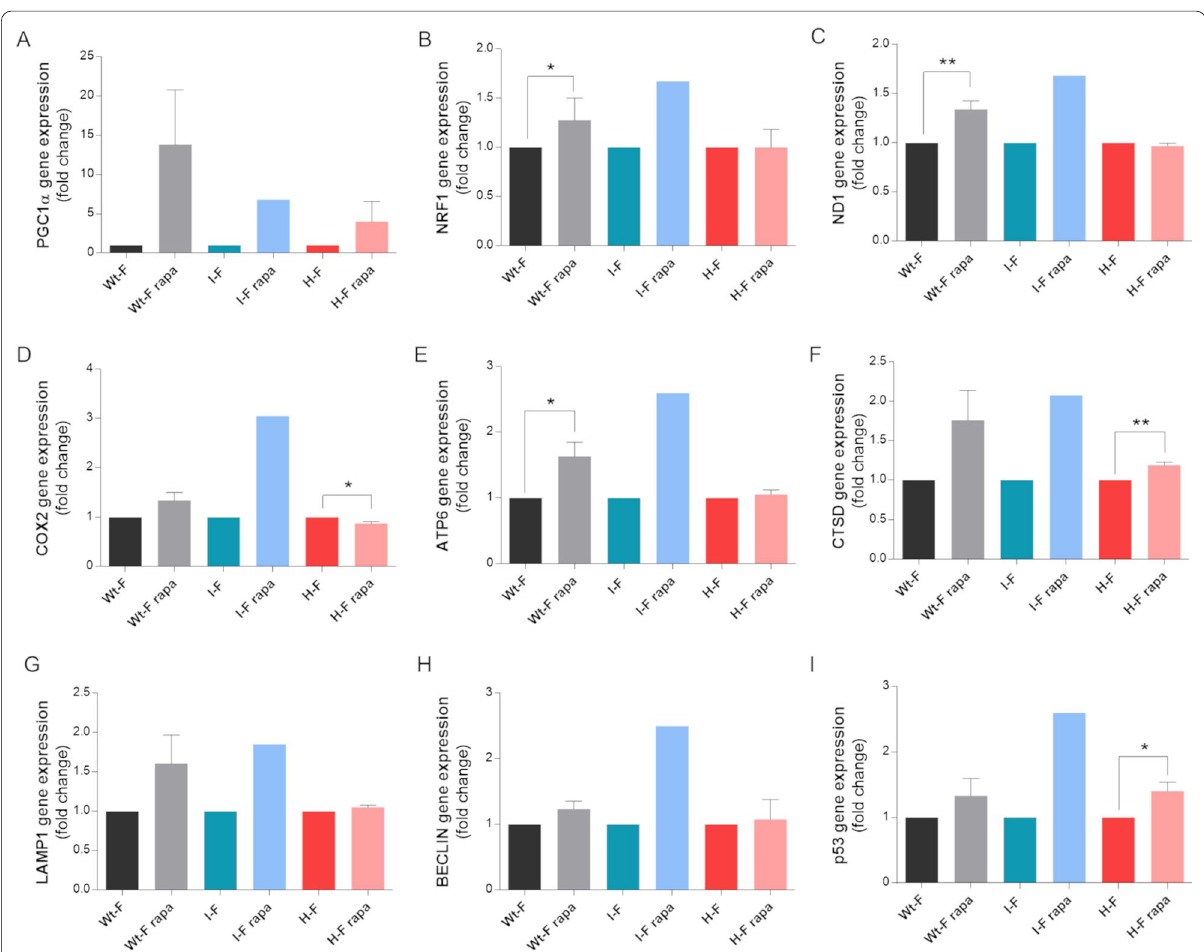
Fig. 7 Gene expression of mitochondrial biogenesis and TFEB pathways in MERRF fibroblasts treated with rapamycin. Wt-fibroblasts, I-fibroblasts and H-fibroblasts were treated four weeks with 20 nM rapamycin. Gene expression of PGC-1α ( A ), NRF1 ( B ), ND1 ( C ), COX2 ( D ), ATP6 ( E ), CTSD ( F ), LAMP1 ( G ), BECLIN ( H ) and p53 ( I ) evaluated by qPCR. ACTIN was used as reference gene. Data are normalized to untreated cells and are means and SD of four biological replicates for Wt-F and three biological replicates for H-F. Only one experiment is reported for I-F. Statistical analyses were performed using unpaired two-tail T-test. P value: *p < 0.05, **p < 0.01, ***p <